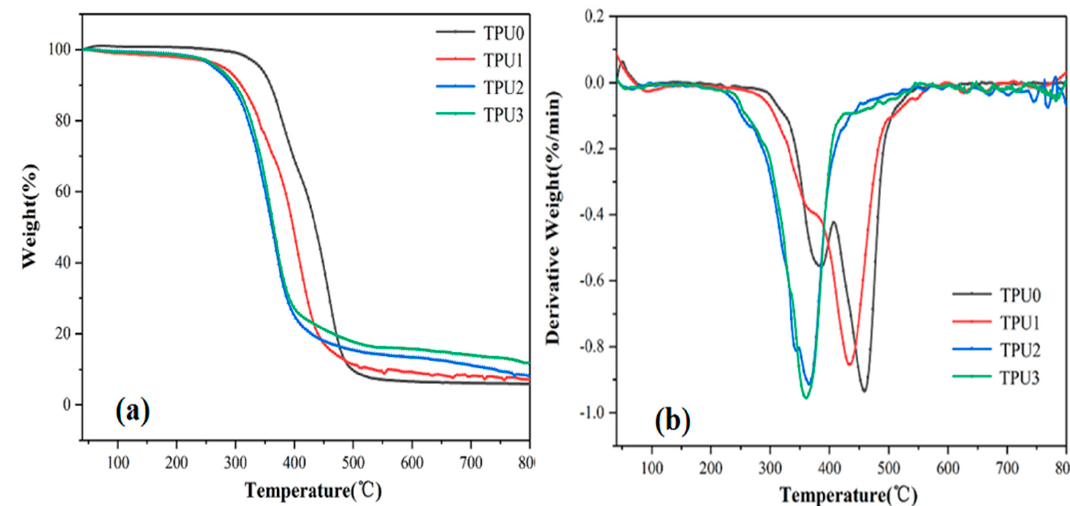
Table 3. Thermogravimetry data of pure TPU and TPU composites.